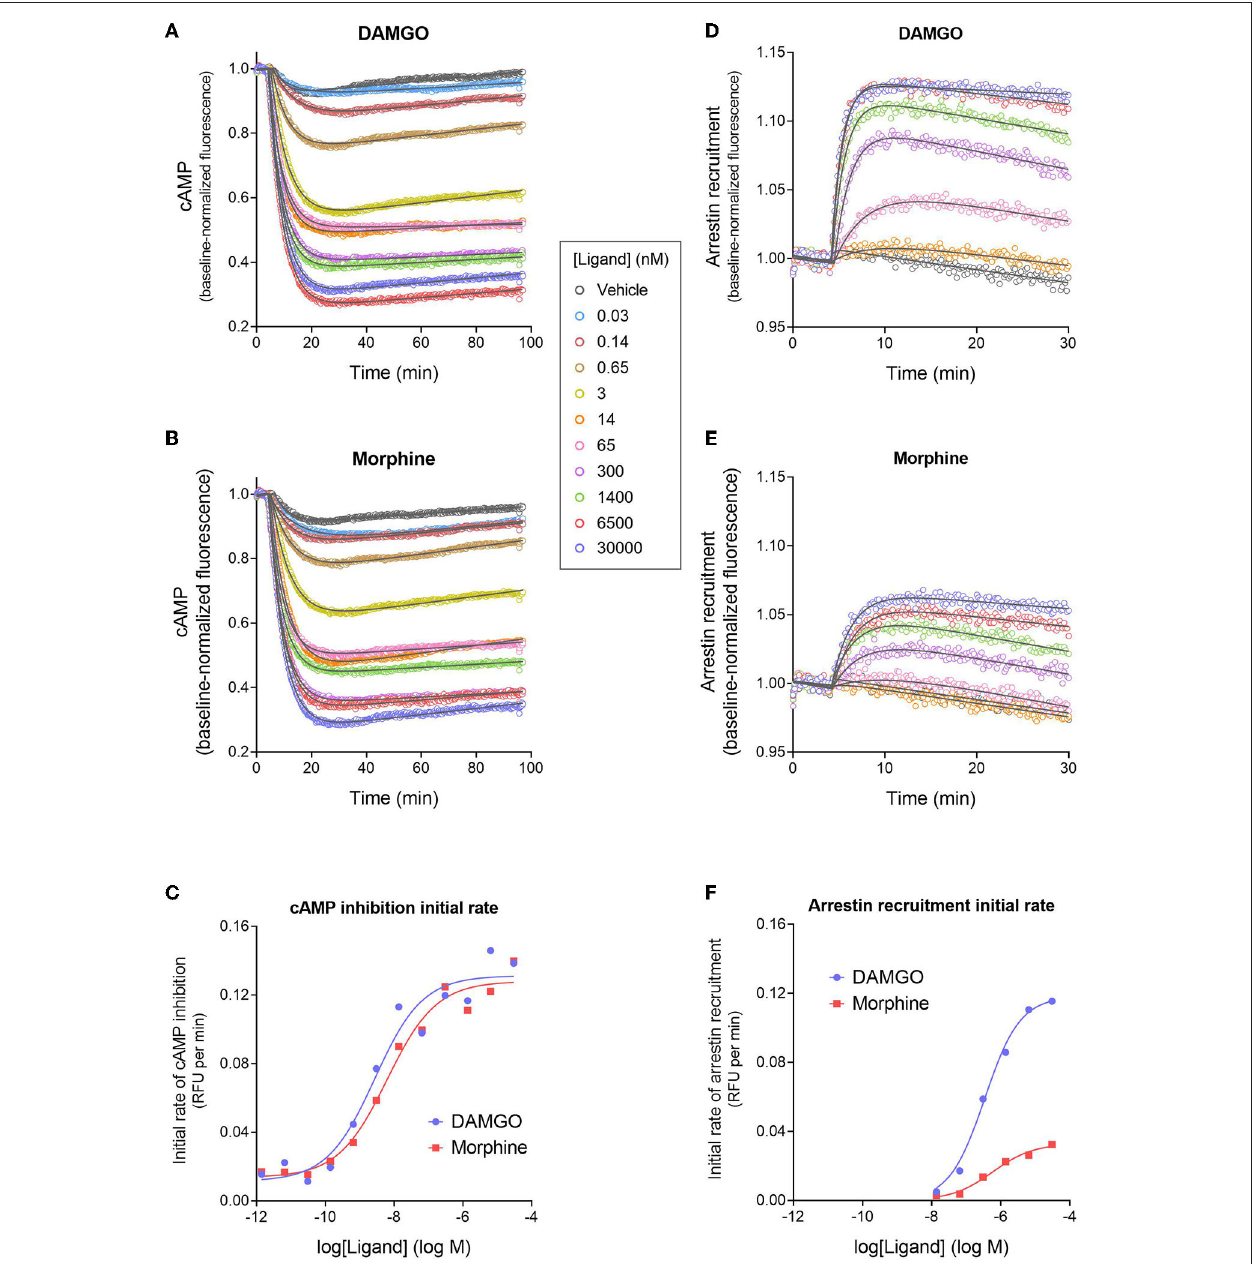
FIGURE 3 | Signaling kinetics and signal generation rate of the µ opioid receptor for inhibition of cAMP production and stimulation of arrestin recruitment. The signals were measured repeatedly over time using fluorescent biosensors in HEK293 cells. (A,B) Time course of cAMP inhibition by DAMGO (A) and morphine (B) . Data were fit to the “Baseline then fall to steady state with drift” equation in GraphPad Prism (gray lines). From the fitted parameter values, the initial rate of cAMP inhibition was calculated using the formula Initial rate = SteadyState × K. In (C) , the initial rate is plotted vs. the DAMGO or morphine concentration and the data fit to a sigmoid curve concentration response equation (Motulsky, 2019). From this fit, the initial rate of cAMP inhibition by the agonist-occupied receptor (IR max ) was determined, as the Span value (Top minus Bottom). Note morphine is a full agonist (IR max of 95 % of DAMGO IR max ). (D,E) Time course of arrestin recruitment to the MOR stimulated by DAMGO (D) and morphine (E) . Data were fit to fit to the “Baseline then rise to steady state with drift” equation in GraphPad Prism (gray lines). The initial rate of arrestin recruitment was calculated from the fit parameters using the formula Initial rate = SteadyState × K. (F) Initial rate of arrestin recruitment vs. agonist concentration. The IR max for the agonists was determined as the Span value of the sigmoid curve fit. Note morphine is a partial agonist (IR max of 28 % of DAMGO IR max ). Data are from a representative experiment. Data points in (A,B,D,E) are the mean of two technical replicates (note, error bars have been excluded for clarity).